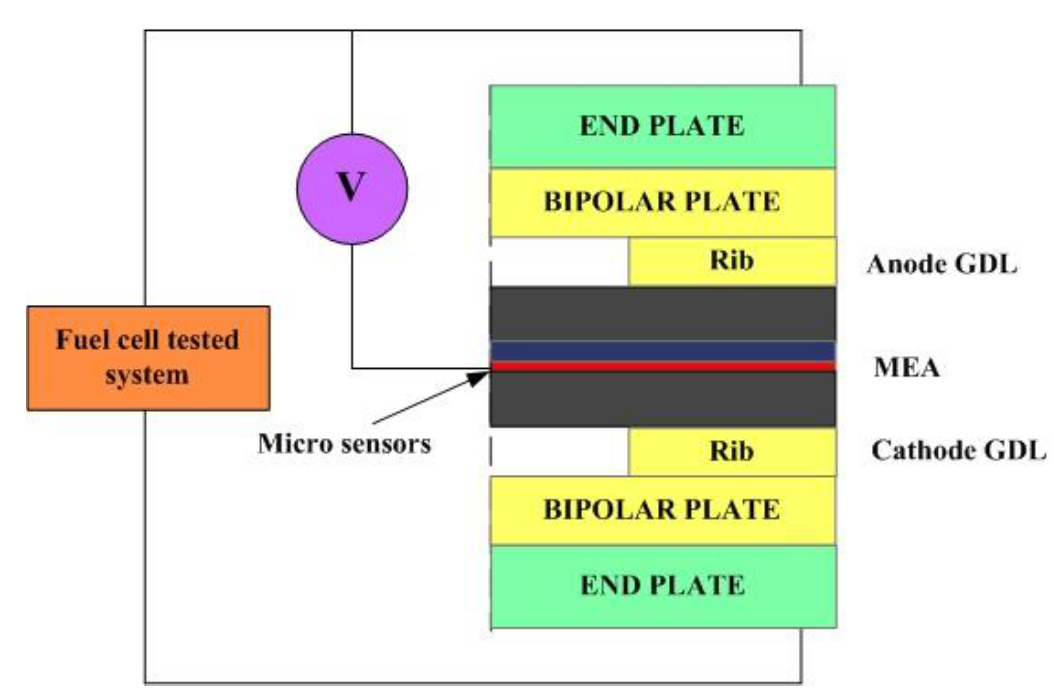
Figure 3. Measurement system